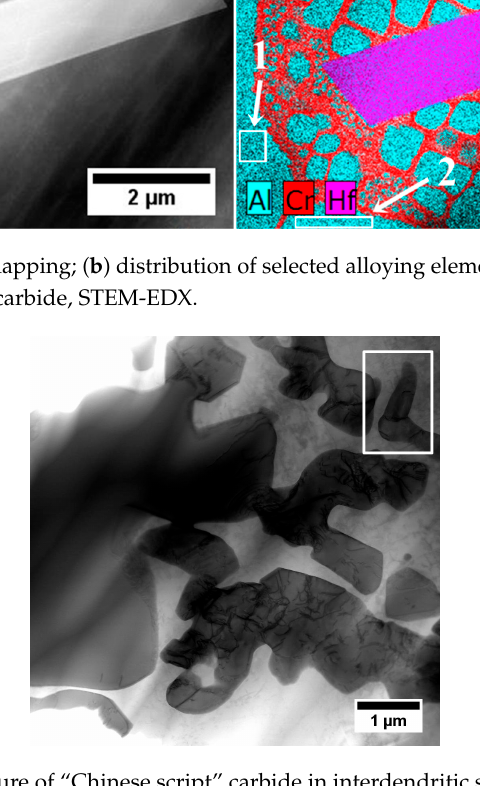
Figure 18. Microstructure of “Chinese script” carbide in interdendritic space, STEM-HAADF. Table 7. Chemical composition of the coarse secondary γ (cid:48) and M 23 C 6 (at the MC carbide edge), at%.